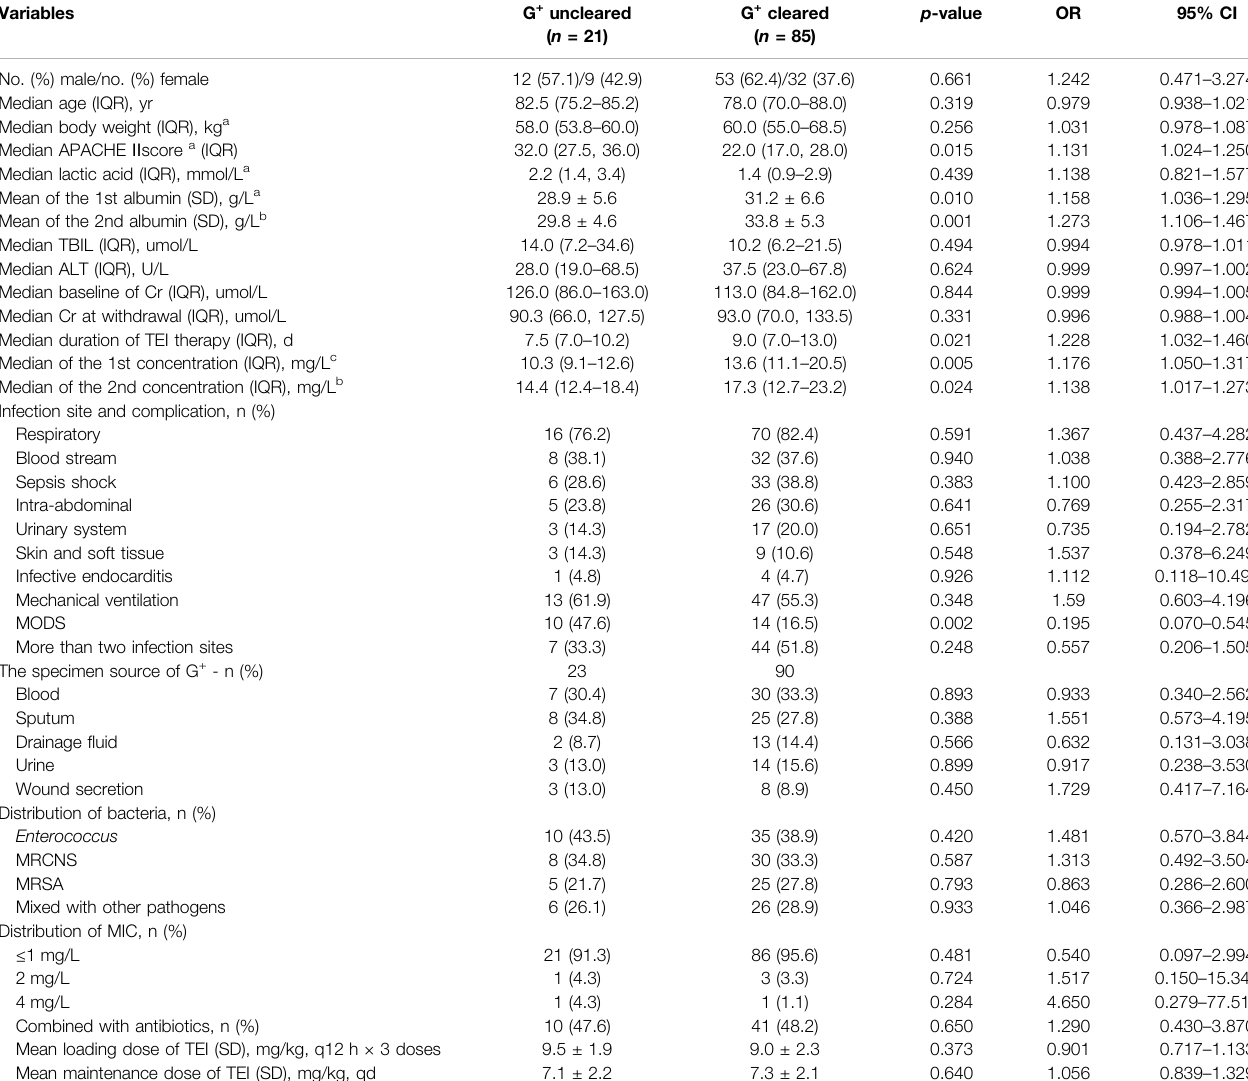
TABLE 3 | Univariate regression analysis of risk factors on clearance of Gram-positive bacteria. Variables G + uncleared